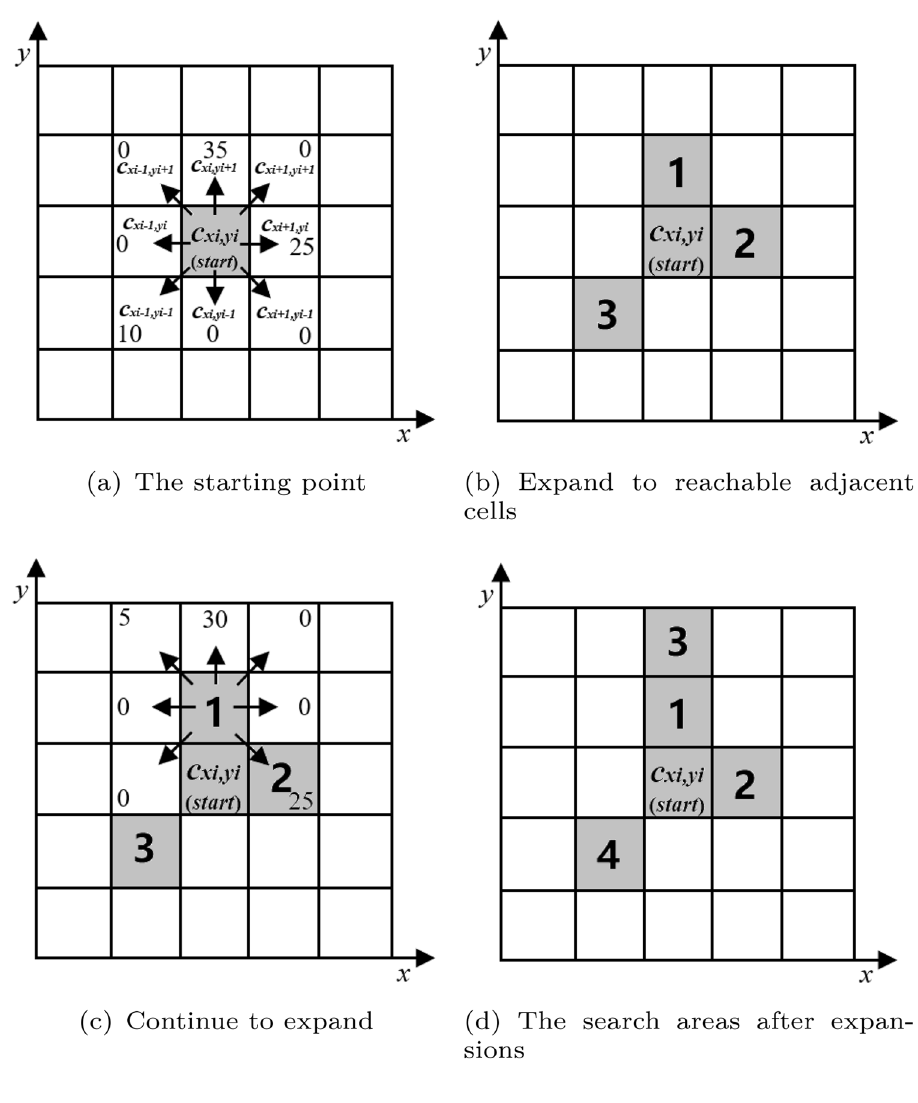
Fig. 11 The process of forming search